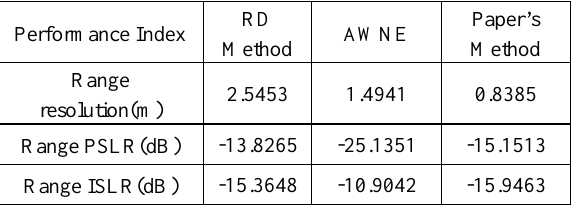
Fig.4. Actual measured SAR data. (a) RD method. (b) AWNE method. (c) The paper’s method. TABLE I Performance Analysis of Different